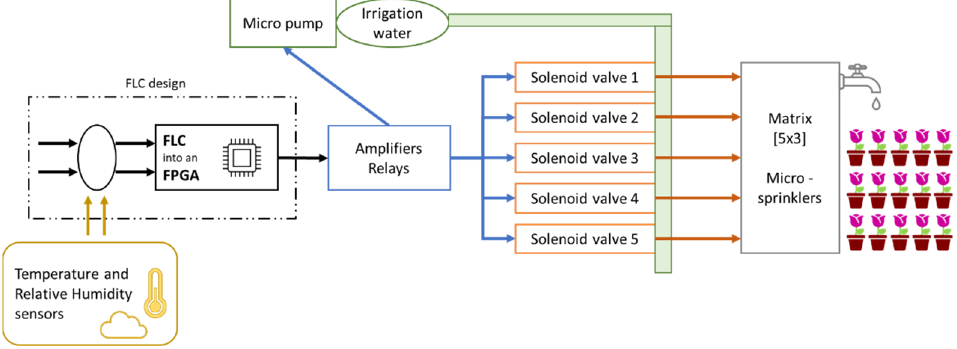
Figure 9. Block diagram representation of the control process implementation for the irrigation in roses.